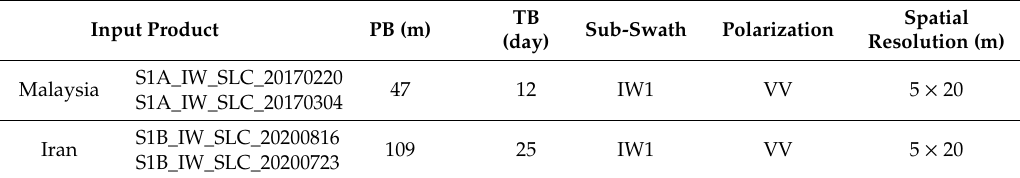
Table 1. Technical characteristics of Sentinel-1 were used in this study.